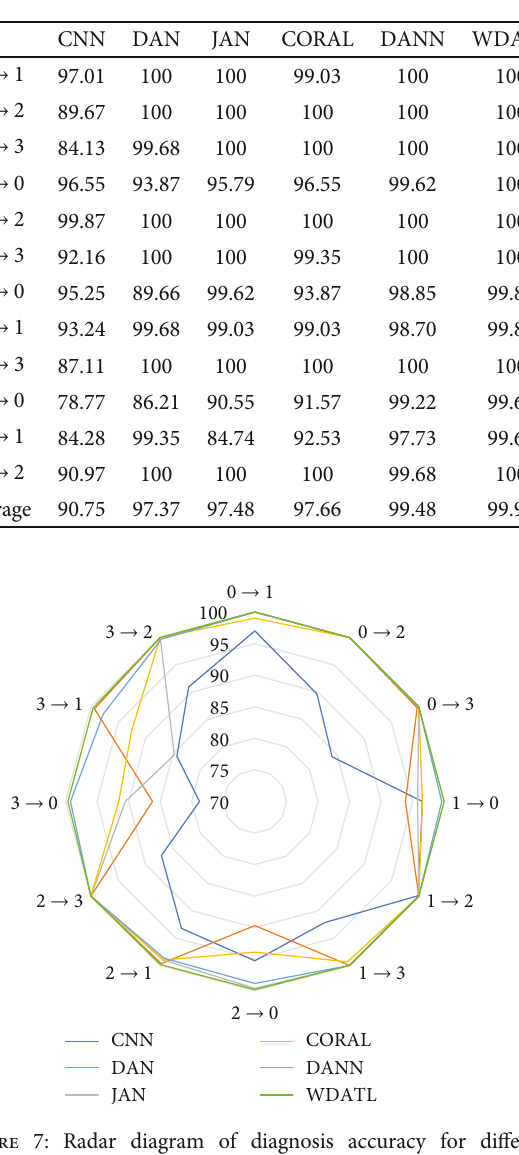
Table 4: Accuracy (%) of di ff erent algorithms for di ff erent working conditions.